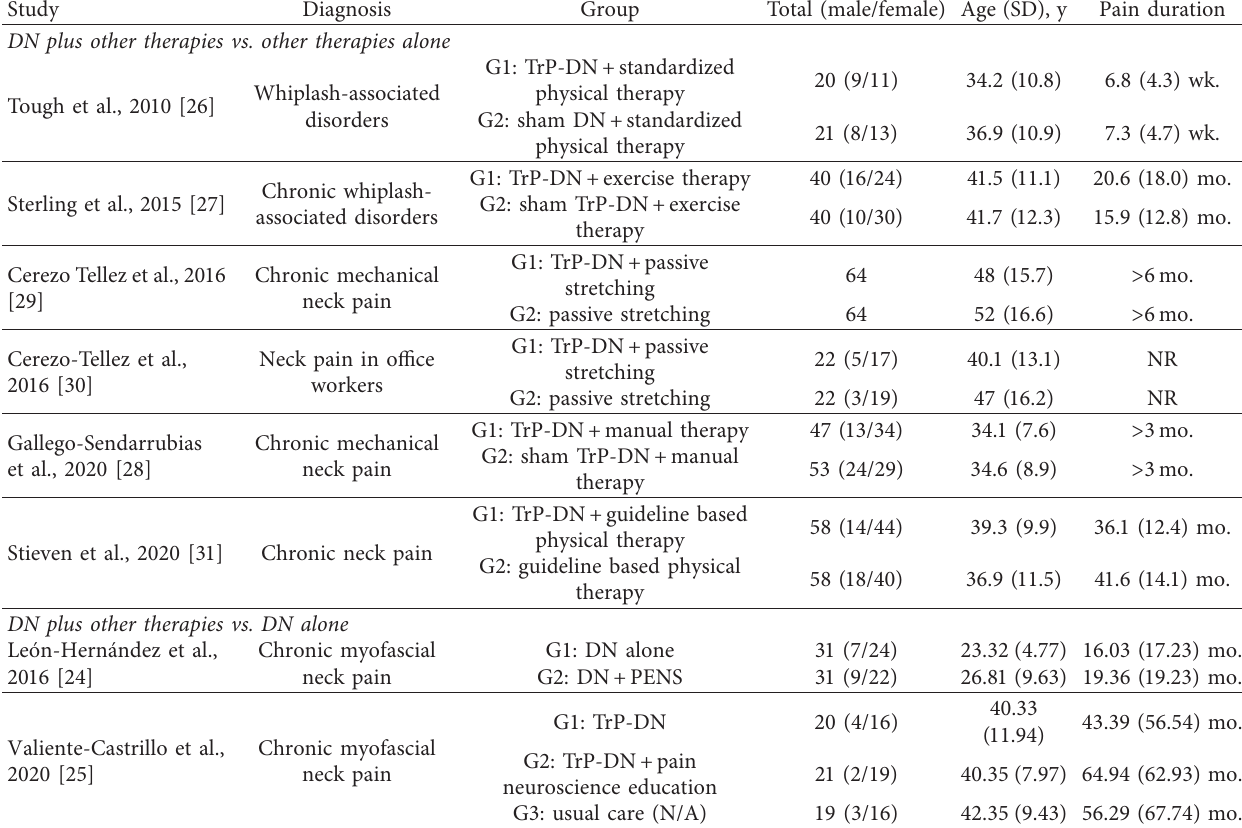
Table 1: Characteristics of the sample of included